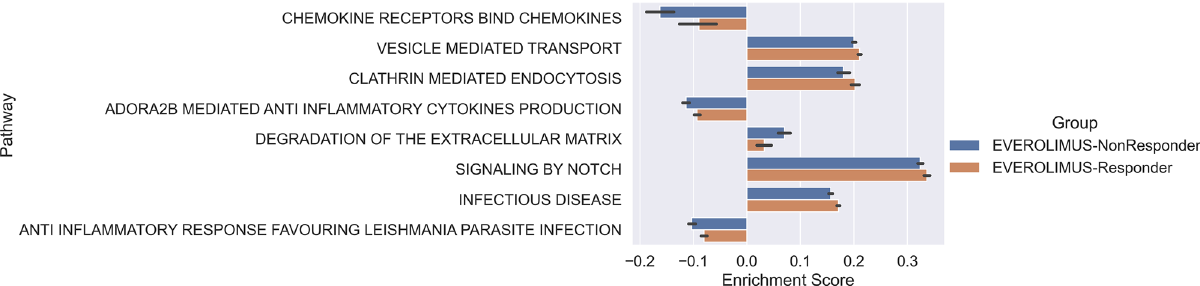
Figure 4. Top pathways contributing to prediction of everolimus treatment outcomes that are also significantly different between everolimus responders and non-responders.